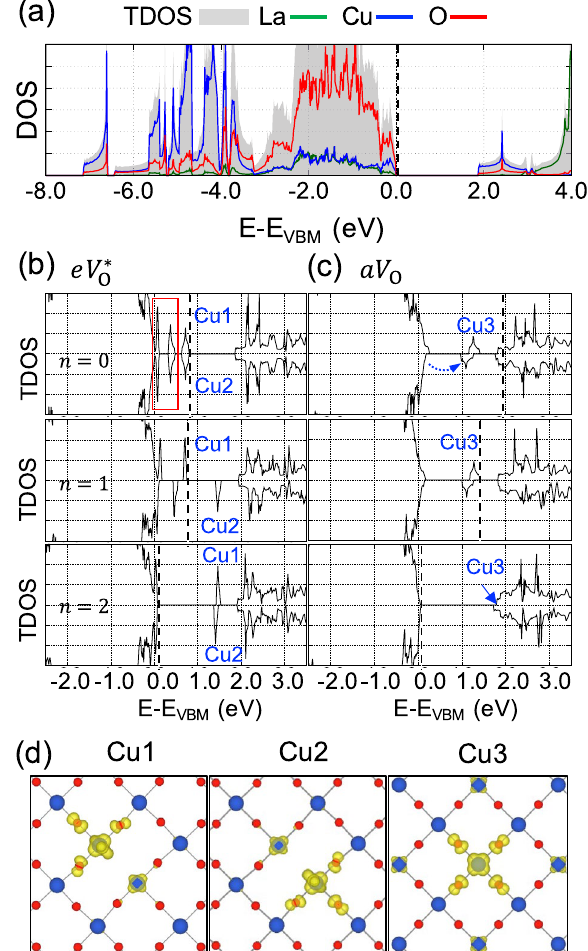
Figure 4. ( a ) Total density of states (TDOS) (grey filled curve) and projected density of state (PDOS) (color lines) on La, Cu, and O of La 2 CuO 4 . Spin-resolved TDOS of La 2 CuO 4 with ( b ) eV O * and ( c ) aV O for various charge states. The scale of TDOS is the same for all six plots of ( b ) and ( c ). Oxygen vacancy states are indicated Cu1, Cu2, and Cu3. The dashed vertical line in each figure indicates the Fermi energy. States in the red rectangle of ( b ) and indicated with dotted arrow in ( c ) are from the occupied d 9 states of Cu. ( d ) Spatial distributions of charge densities of three states marked in ( b ) and ( c